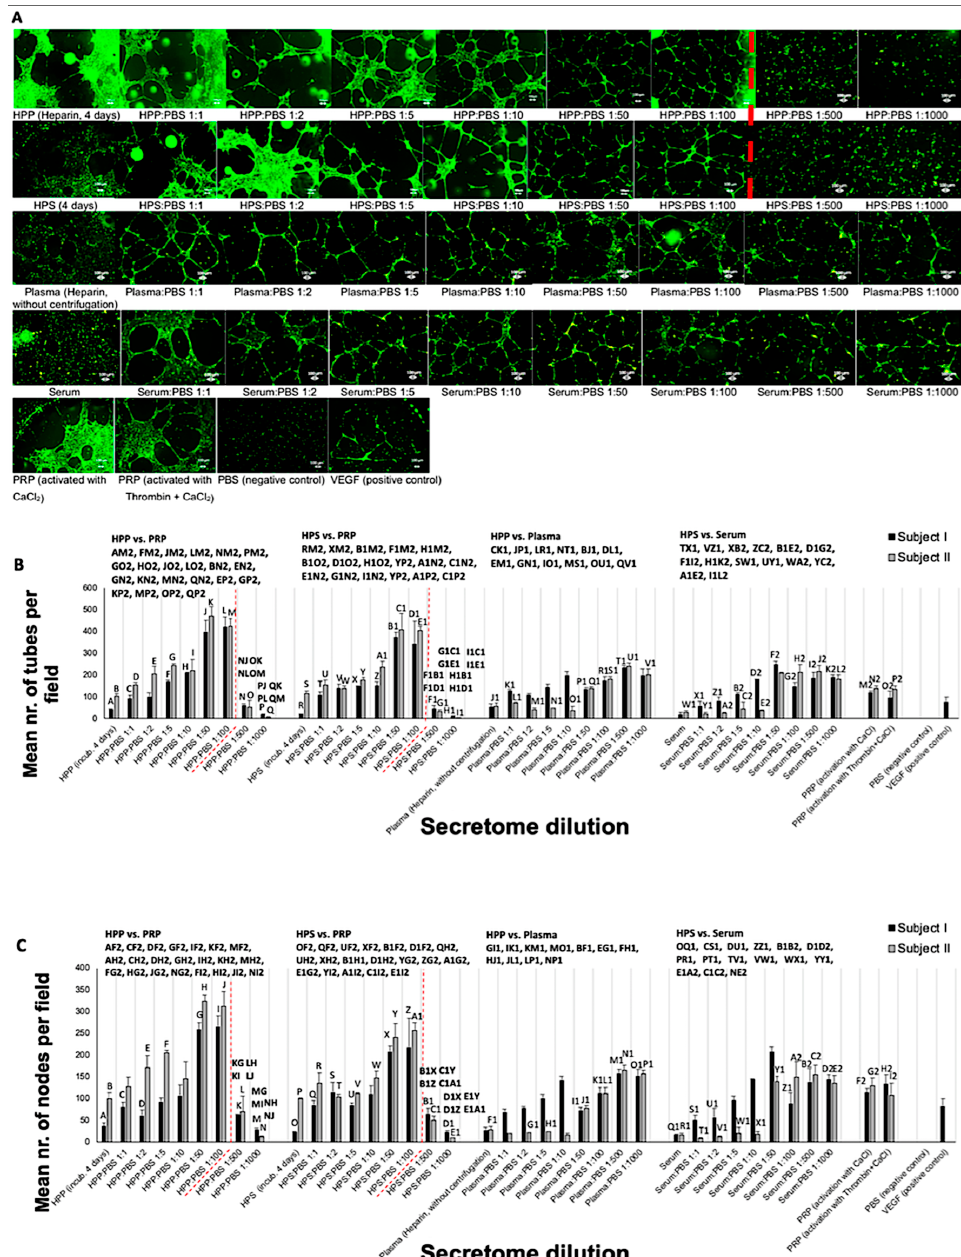
Figure 6. Effect of hypoxia preconditioned secretome dilution on microvessel formation in HUVEC cultures in vitro. ( A ) Panel showing representative images of the tube formation assay (12 h), carried out in the presence of the shown diluted blood-derived secretomes (Bars = 100 μ m). ( B , C ) Plot showing the mean number of tubes ( B ) and nodes ( C ) formed in cultures with different blood-derived secretome and basal control dilutions (1:1 to 1:1000), for blood obtained from two individual subjects ( n = 3 per subject). The red dashed line indicates the statistically significant cut-off point of dilution. Capital letter pairs shown directly above histograms indicate intra-condition statistical comparison of corresponding data points, while HPP/HPS vs. Plasma/Serum and HPP/HPS vs. PRP statistical comparisons are shown on the upper part of plot B and C. For all pair comparisons p < 0.05, unless otherwise indicated. Error bars represent s.d.